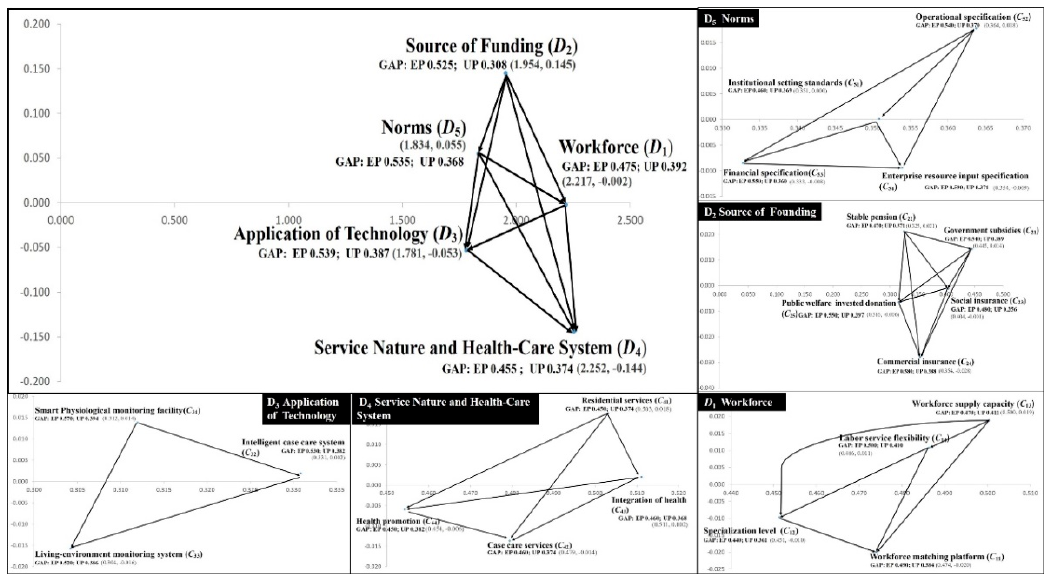
Figure 3. Influential network relation map (INRM) of the total influence relationships.